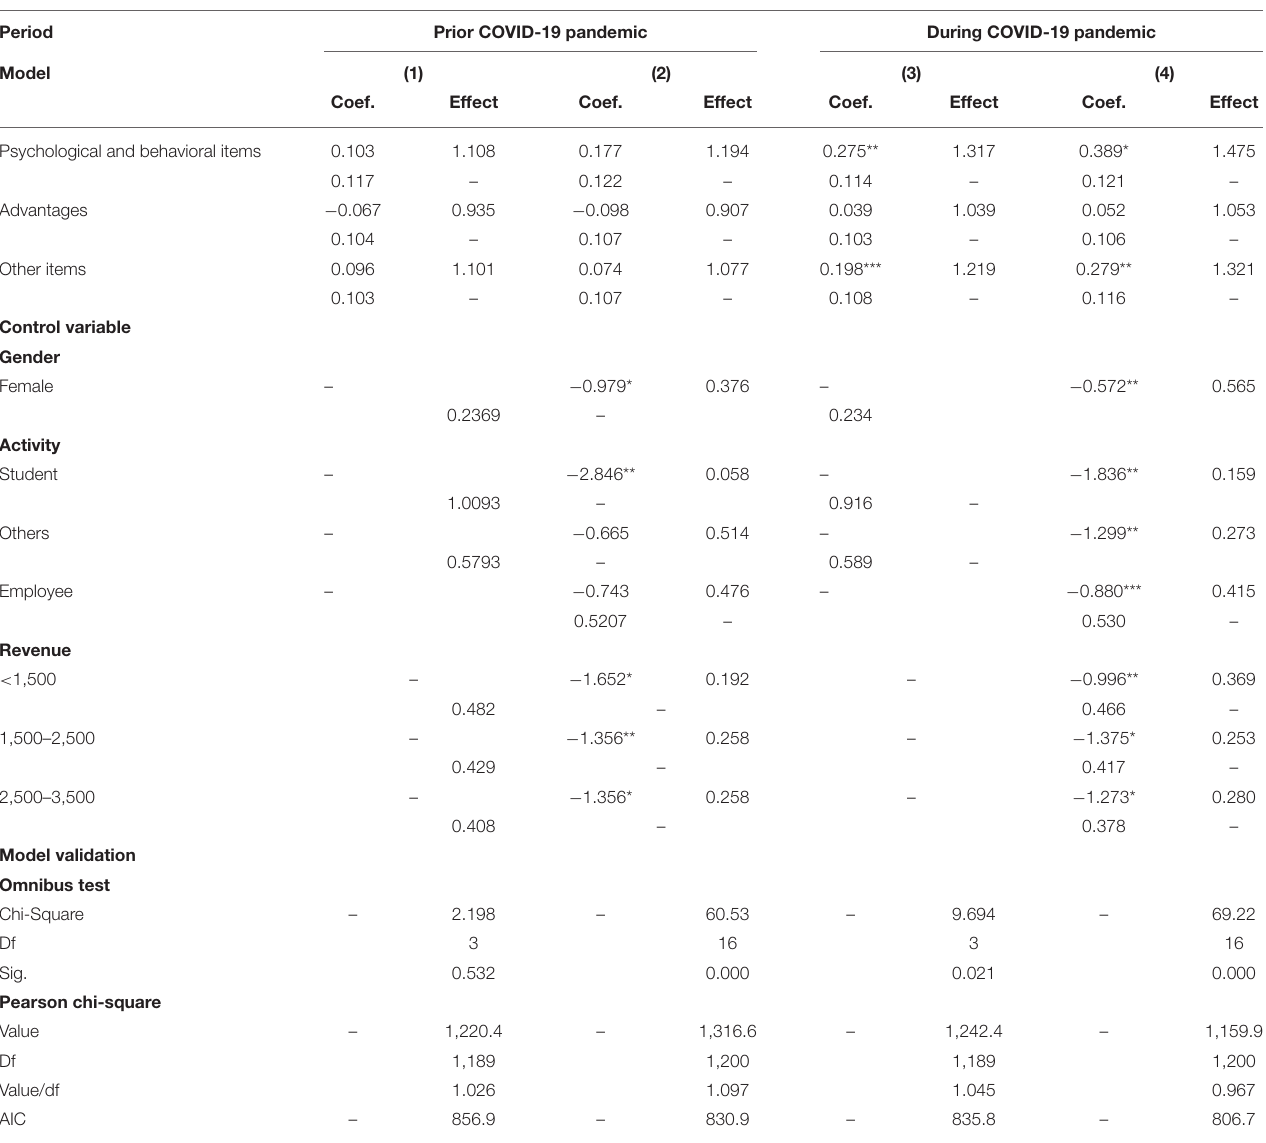
TABLE 11 | GLM regression model